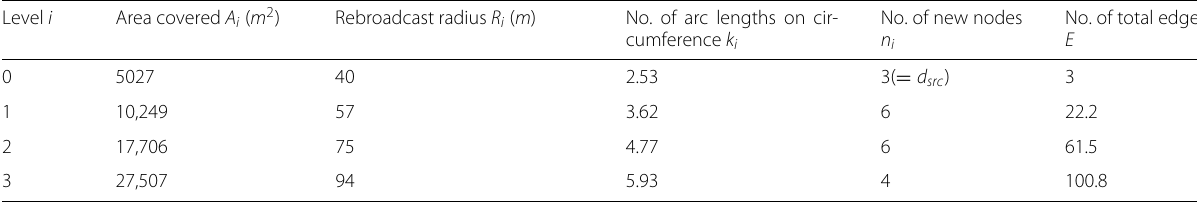
Transmission radius = 40m; average distance from a transmitting node to a neighbor = 26 m; θ when average additional coverage is 41%=2.48 radians (142°); deg average node